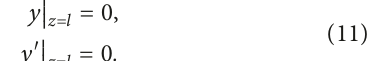
Figure 3: Simplified p - y model of laterally loaded piles in sloping